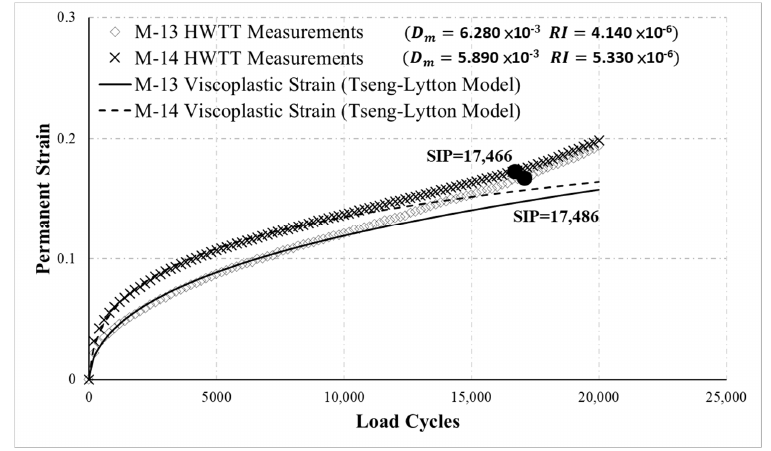
Figure 12. HWTT results for M-13 and M-14.